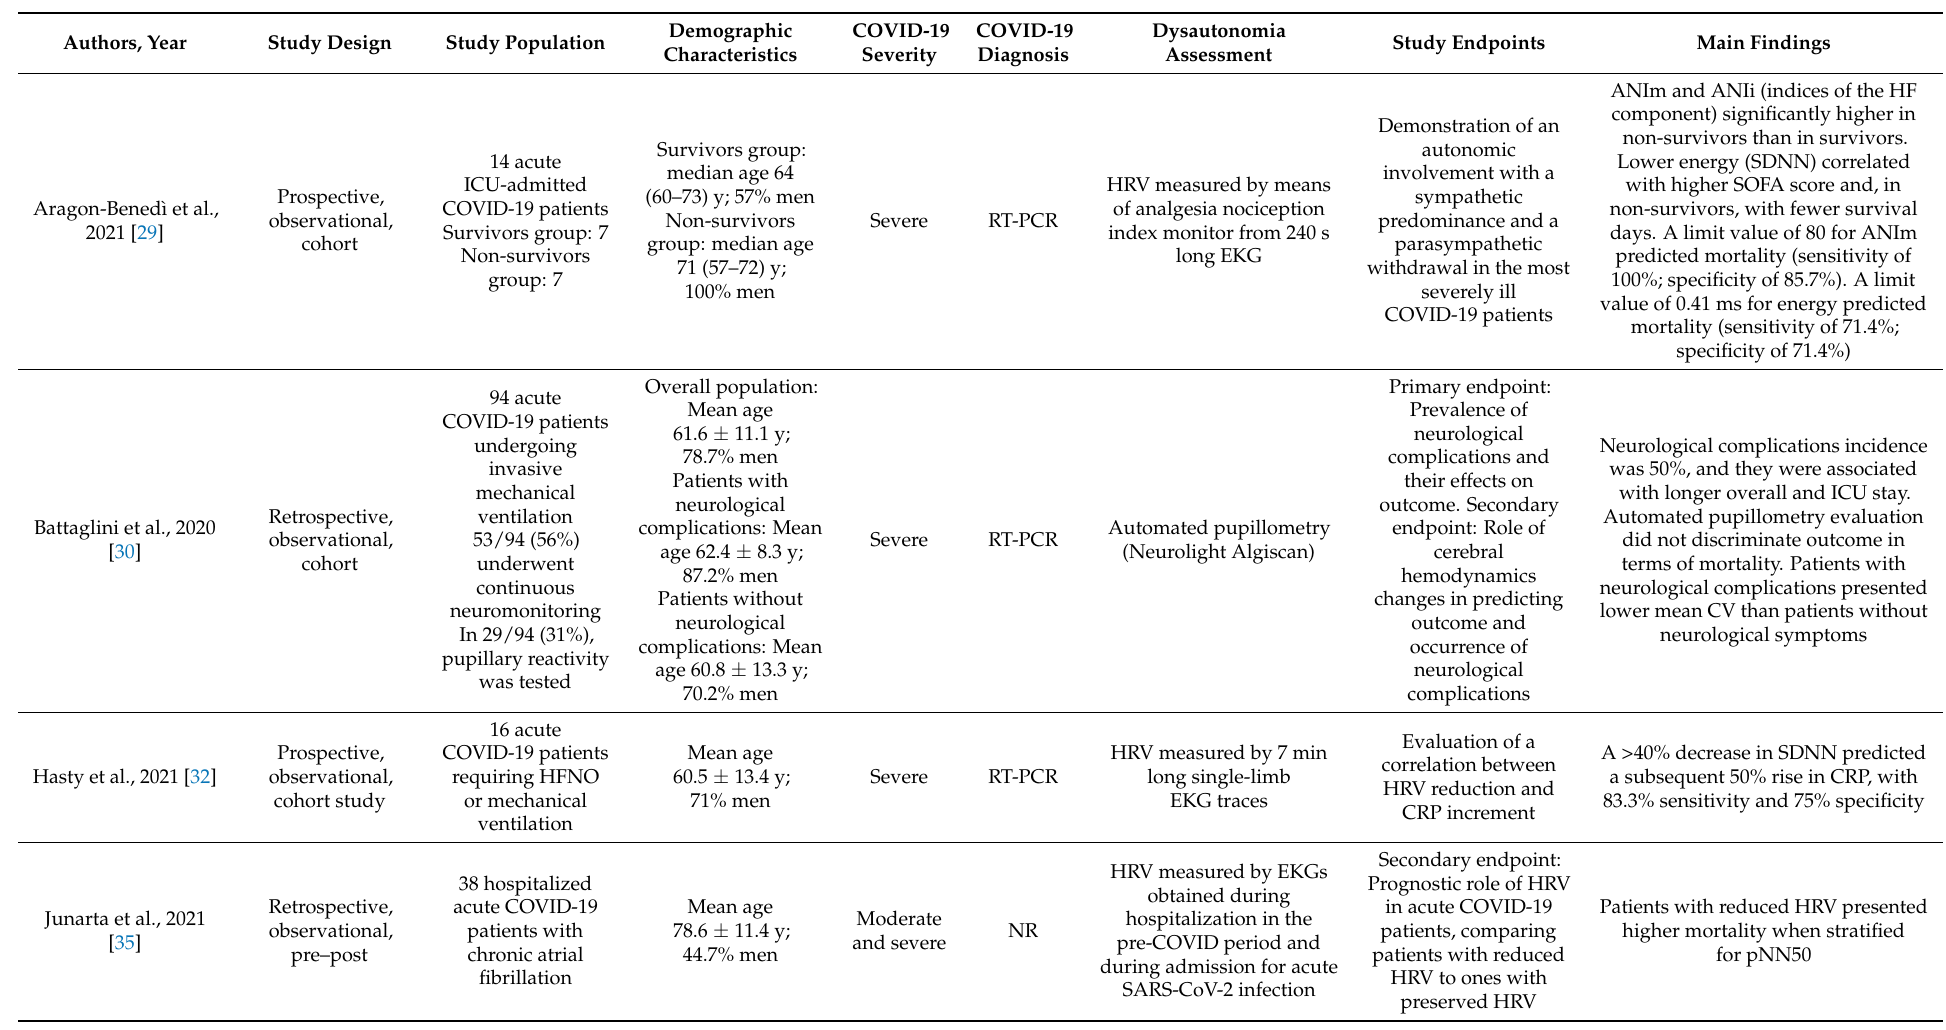
Table 3. A table summarizing the data extracted from the nine studies investigating the prognostic role of autonomic dysfunction in acute